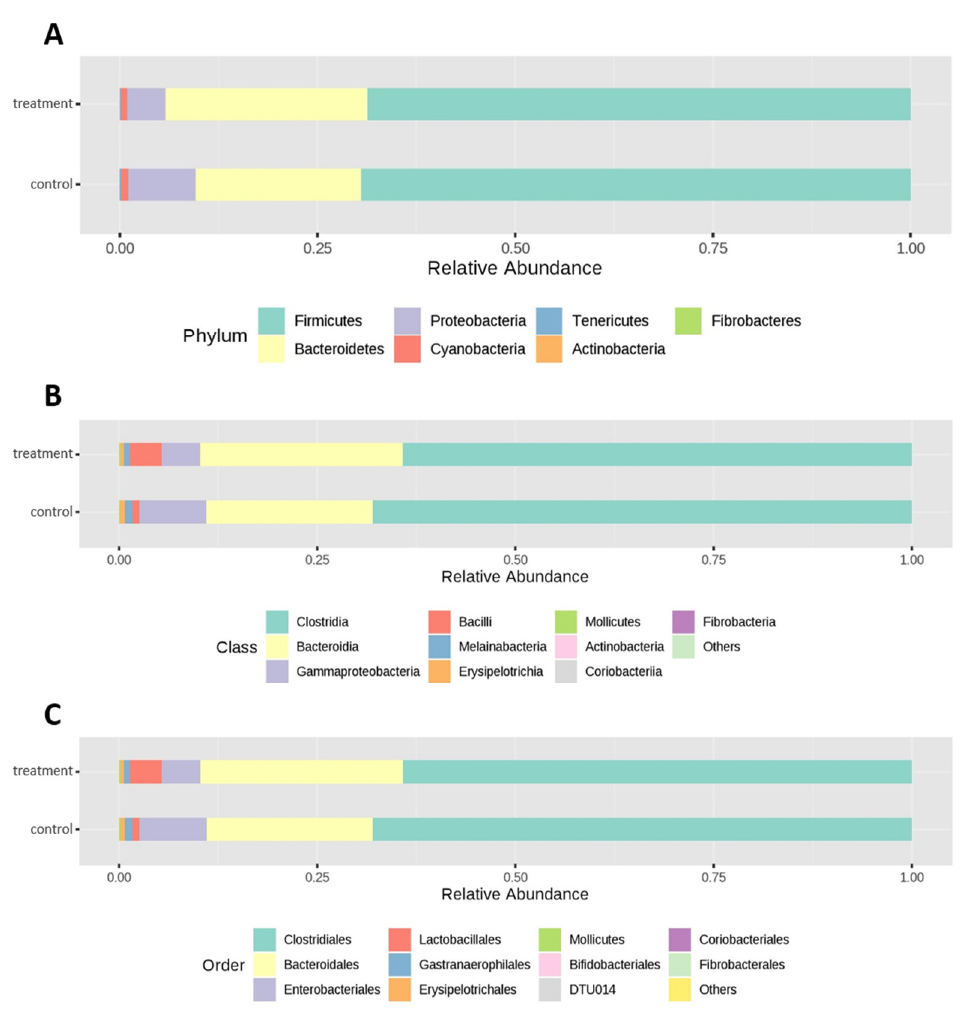
Figure 1. Relative abundance in control and treated groups at different taxon levels: ( A ) phylum, ( B ) class and ( C ) order. Classes and orders with counts <10 are merged and reported as “others”.